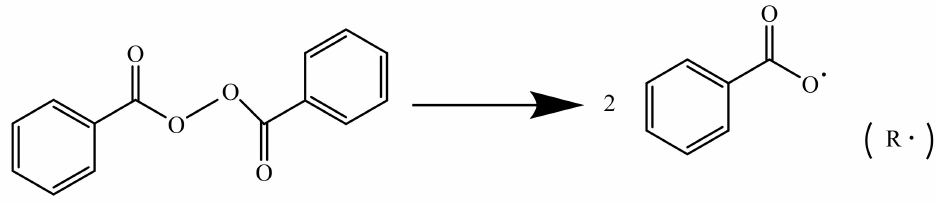
Figure 2. The disintegration reaction of benzoyl peroxide into free radical.